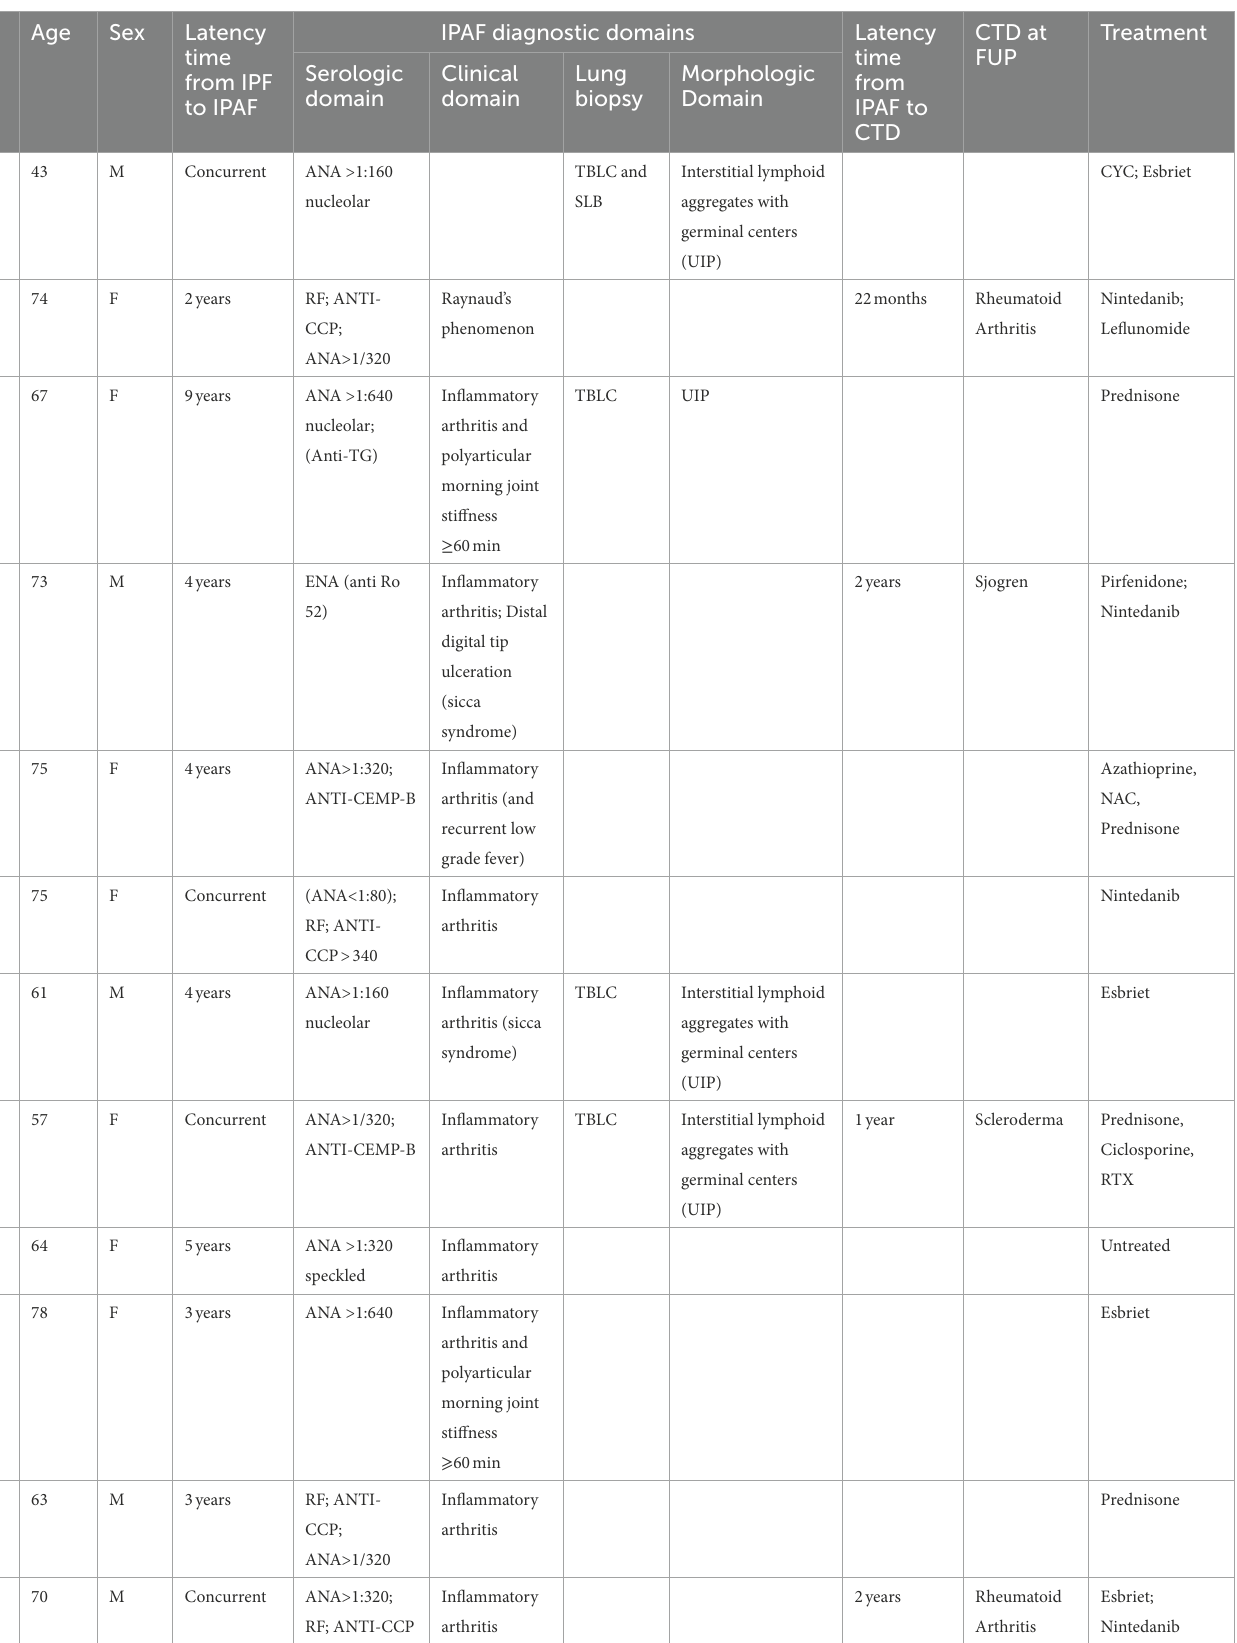
TABLE 2 IPAF/IPF cases